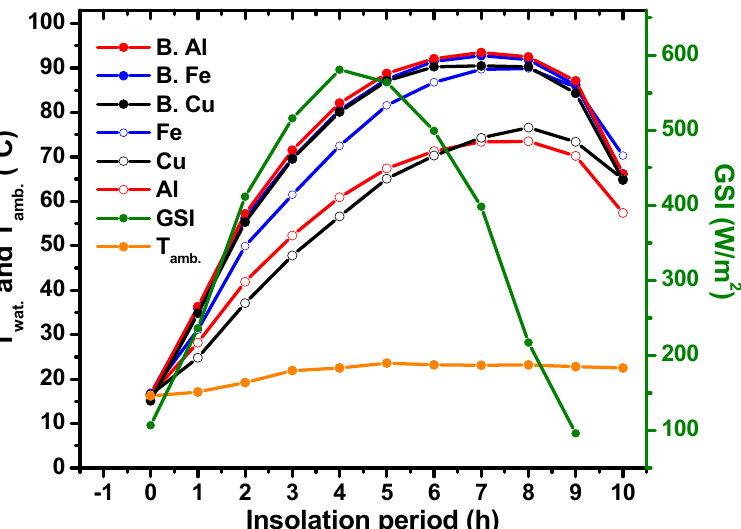
Figure 7. Water and ambient temperatures (T wat . and T amb .) and global solar intensity (GSI) against insolation period for three types of metal containers, Al, Cu, and Fe, bare and matte-black-painted, with 1 mm thickness in all cases; starting time: 7:00 a.m.; sunny day; date: 07/11/2021, Amman, Jordan.